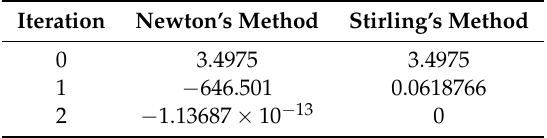
Table 1. Iteration of Newton’s and Stirling’s method with different starting points.